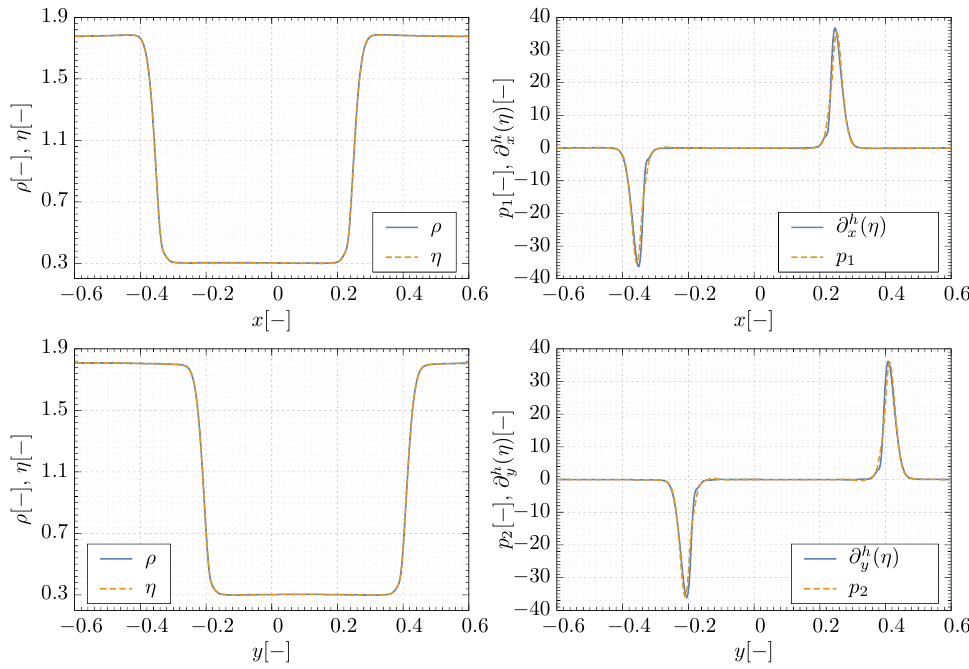
Figure 12. Comparison of the density profile with the order parameter η (top) and of the gradient field components p 1 and p 2 with ∂ h x ( η ) and ∂ h y ( η ) , respectively, computed with finite differences. The comparison is made at t = 5, on two extracted lines from the results of Figures 10 and 11, defined by 0.05 ( right ). y = 0.1 ( left ) and x = −